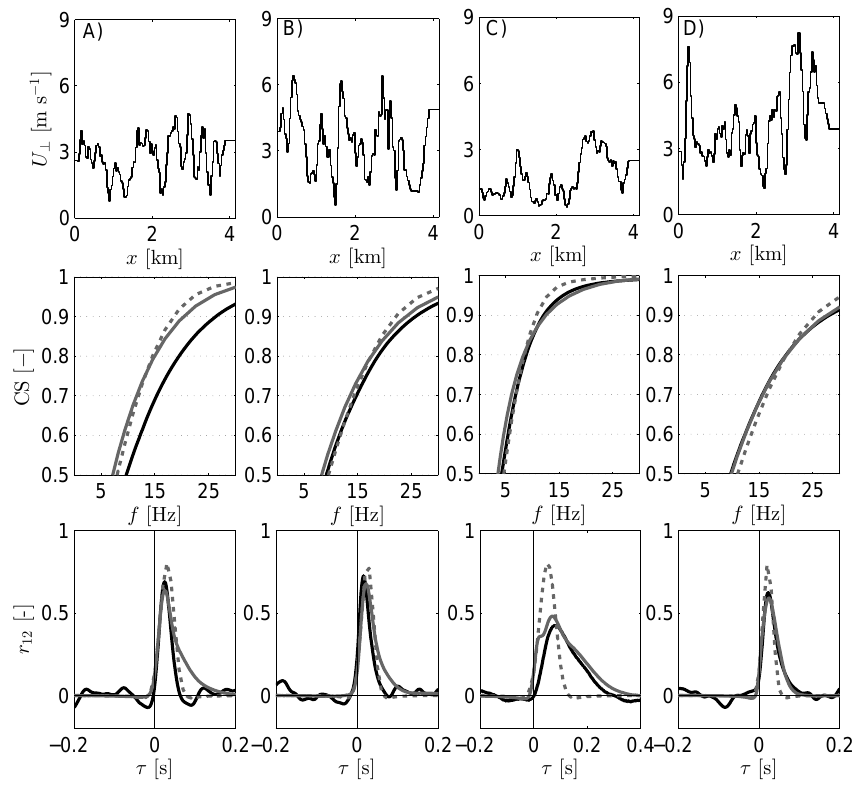
Figure 7. Four cases (A, B, C, and D): in the top panels the transect of U ⊥ (x) , in the middle panels the corresponding CS, and in the lower panels the corresponding r 12 (τ) . The estimated CS and r 12 (τ) of the scintillometer are given as black solid lines, the theoretical CS and r 12 (τ) given U ⊥ (x) of the Doppler lidar are given as solid grey lines, and the theoretical CS and r 12 (τ) given U ⊥ (x) = U ⊥ are given as dashed grey